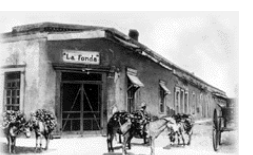
Figure 1: Burros (Courtesy Museum of New Mexico)